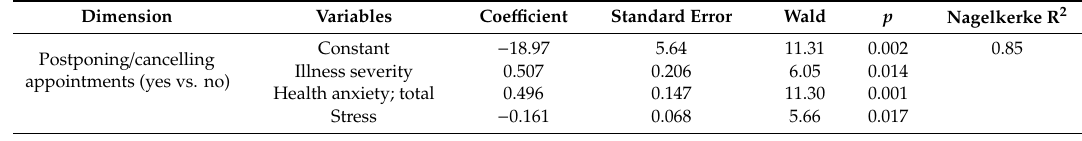
Table4. Binarylogisticregressionanalysiswithpostponedorcancelledroutinehealthcareappointments (yes vs. no) as dependent variable, and illness severity, health anxiety and stress as predictors. Dimension